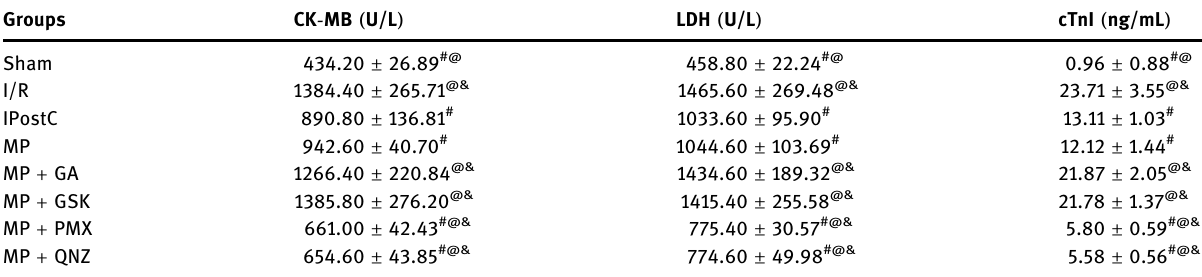
Table 1: Levels of CK - MB, LDH, and cTnI in serum Groups